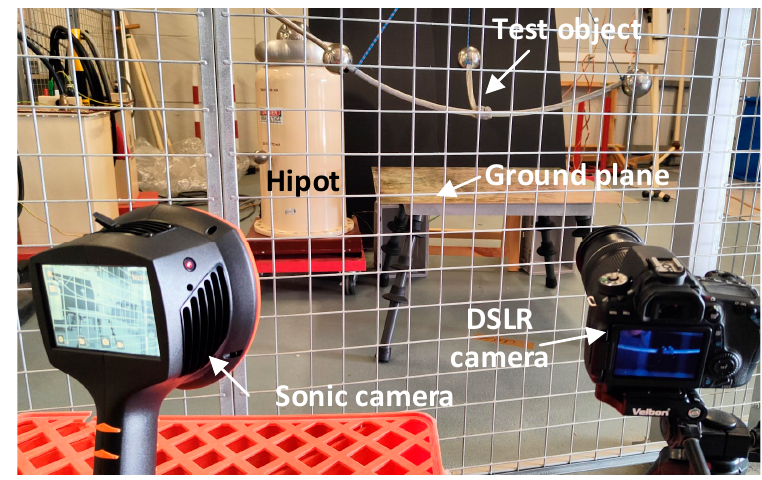
Figure 3. Experimental setup. Analyzed Test Objects Different test objects were used to generate the corona discharges, including a sphere-plane air gap, a needle- plane air gap, and a substation connector, which are shown in Figure 4.